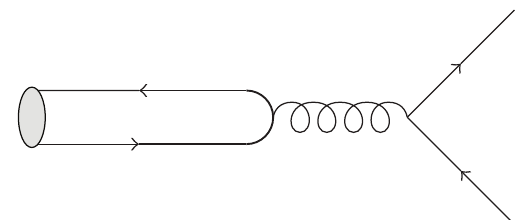
Figure 7: QCD-induced annihilation decay of 𝜔 8 into light quark pair (dijets) or 𝑡𝑡